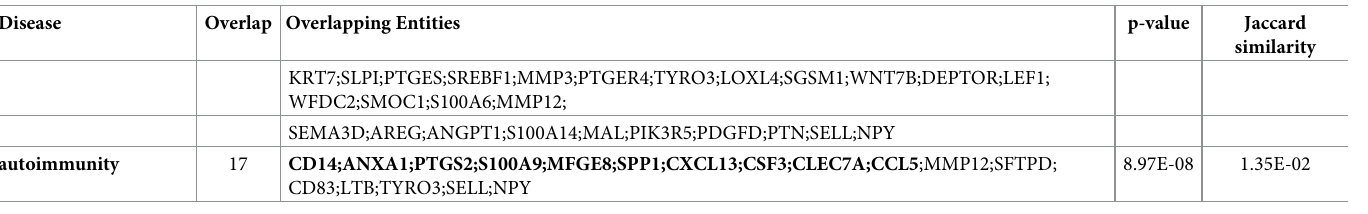
Table 2. Genes modulated by DMHCA that positively correlate with increased progression-free survival in breast cancer subjects.